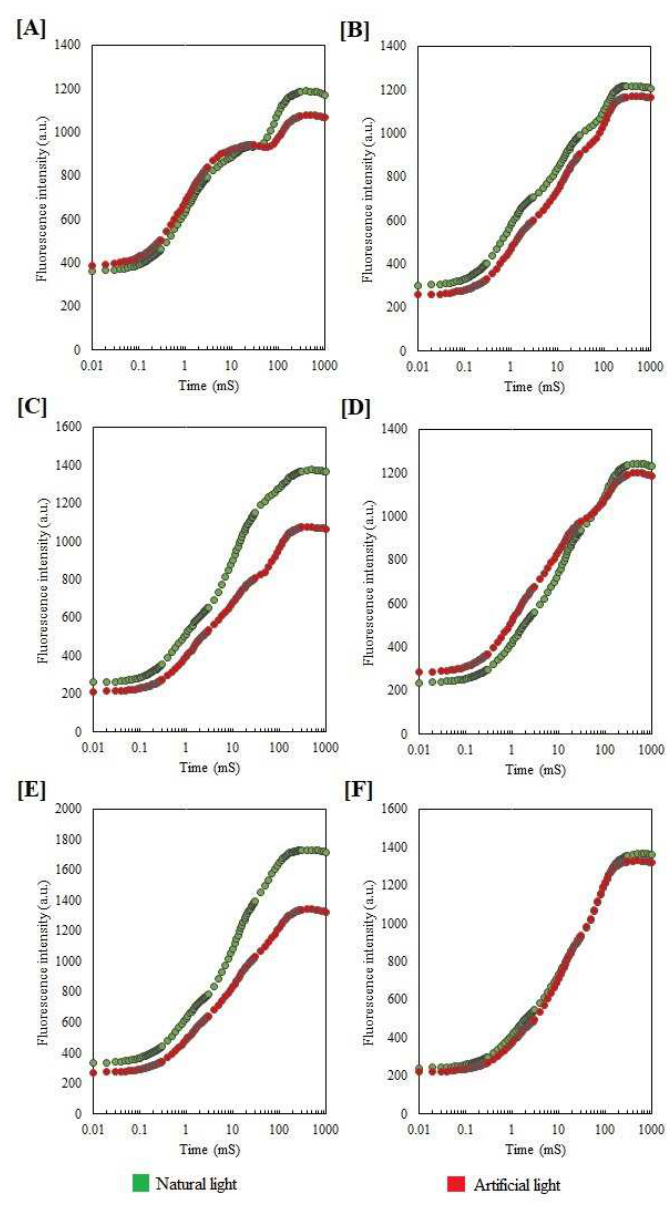
Figure 1. Raw OJIP chlorophyll a transient and kinetic differences of S. asoca ( A ), T. catappa ( B ), B. variegata ( C ), H. integrifolia ( D ), F. benjamina ( E ) and T. peruviana ( F ) growing under artificial-light and natural-light conditions. Each curve represents the average of three independent